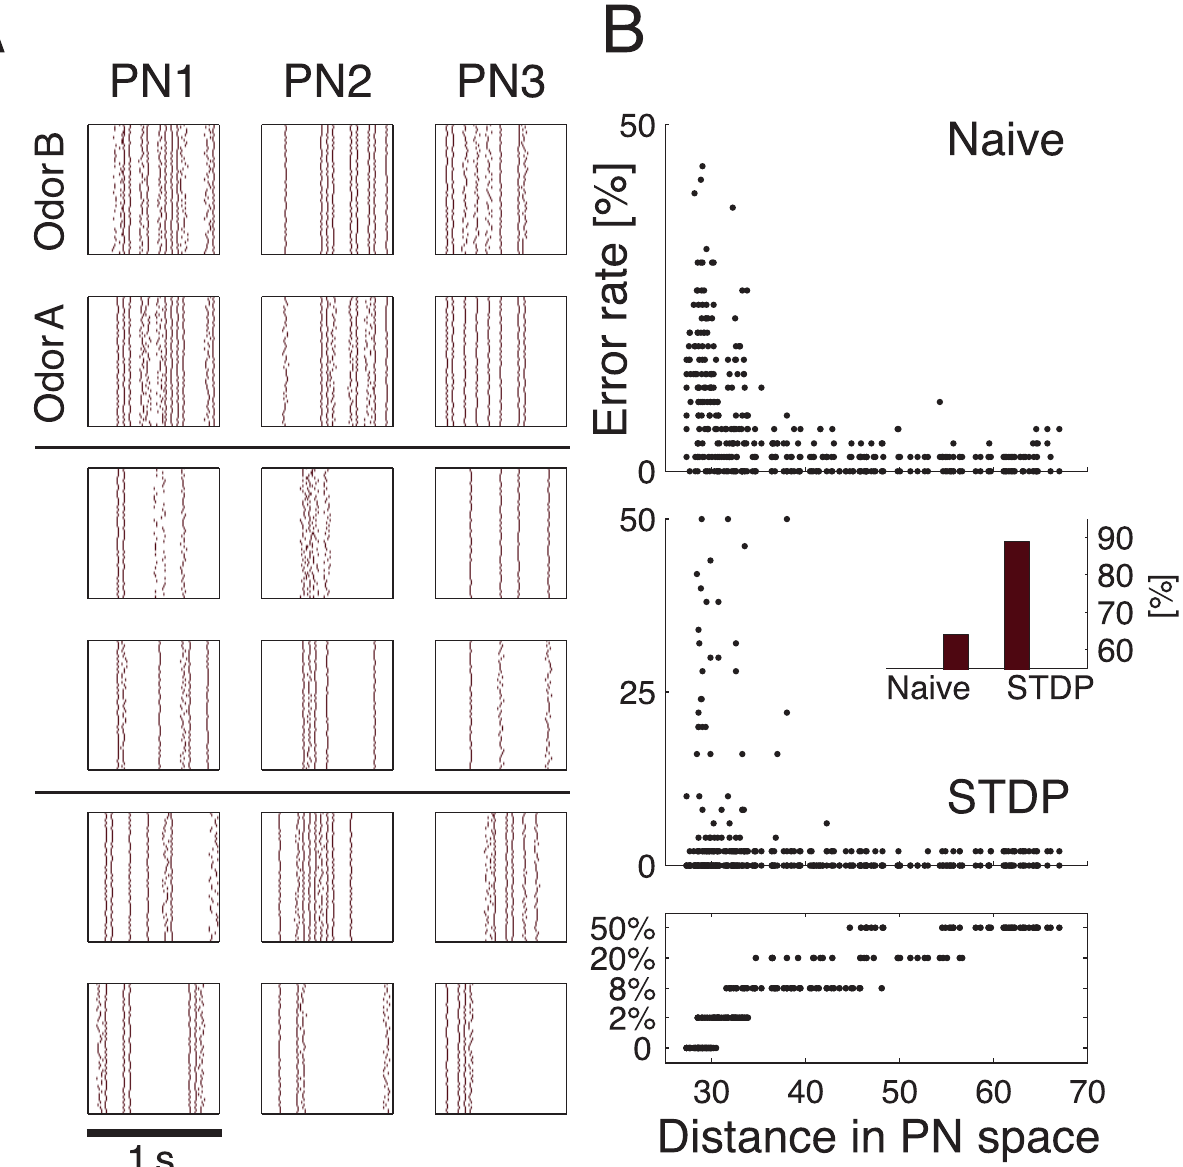
Figure 8. Discrimination in MB versus intrinsic distance in AL. (A) Three odor pairs with identical (upper rows) or different (middle rows: 20% different; bottom rows: totally different) slow temporal structure in AL representation (three cells; spike rasters for 50 trials). Note how the spiking pattern of each PN becomes more and more different when divergence in PN space increases between the two odors. (B) Discrimination error in KC space for a naive system (top panel) and after learning with STDP (middle panel). In each panel a dot represents an odor pair (as in [A]) extracted from one of five sets of 10 odorants (bottom panel) with increasing degree of slow structure dissimilarity in PN space (abscissa) for pairs within the set. For each pair the classification error in KC space is computed as in Figure 7A. Note how plasticity particularly improves classification for odor pairs that have a very similar slow structure representation in PN space. Insert: Global enhancement of discrimination capacity after learning indicated as the proportion of odor pairs with classification error lower than